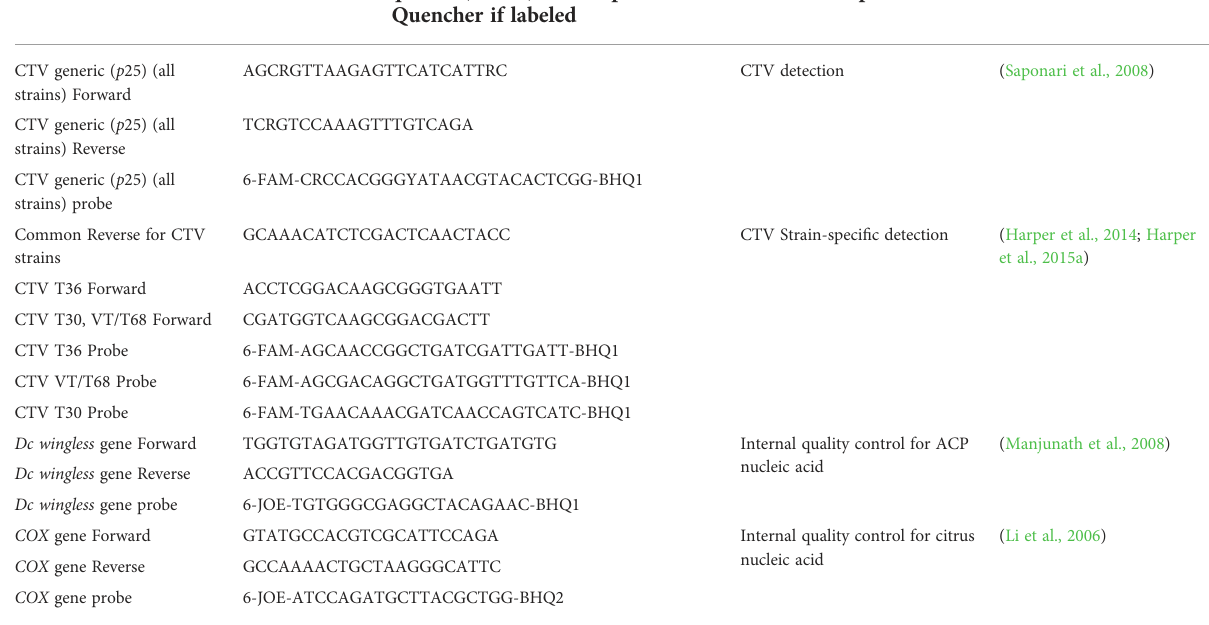
TABLE 1 List of primers and probes used for citrus tristeza virus (CTV) generic and strain-speci fi c detection in citrus trees and Asian citrus psyllids ( Diaphorina citri ; ACP). Primer or